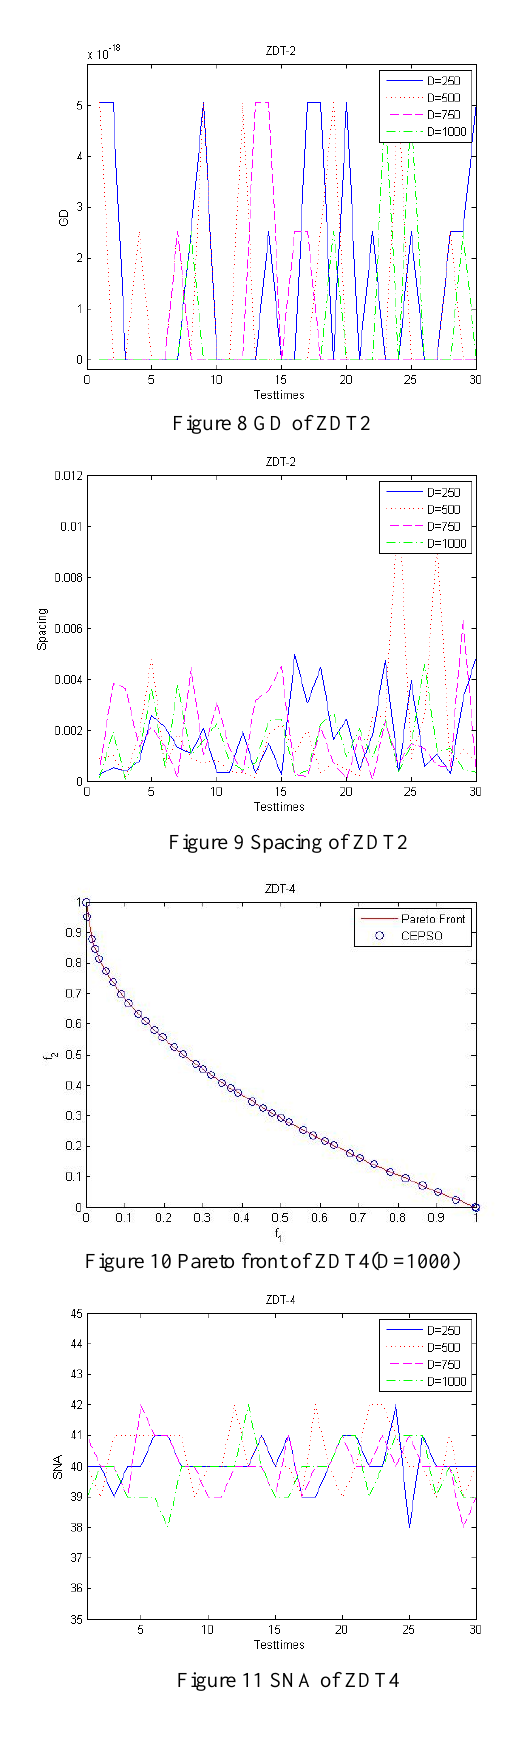
Figure 11 SNA of ZDT4 Figure 7 SNA of